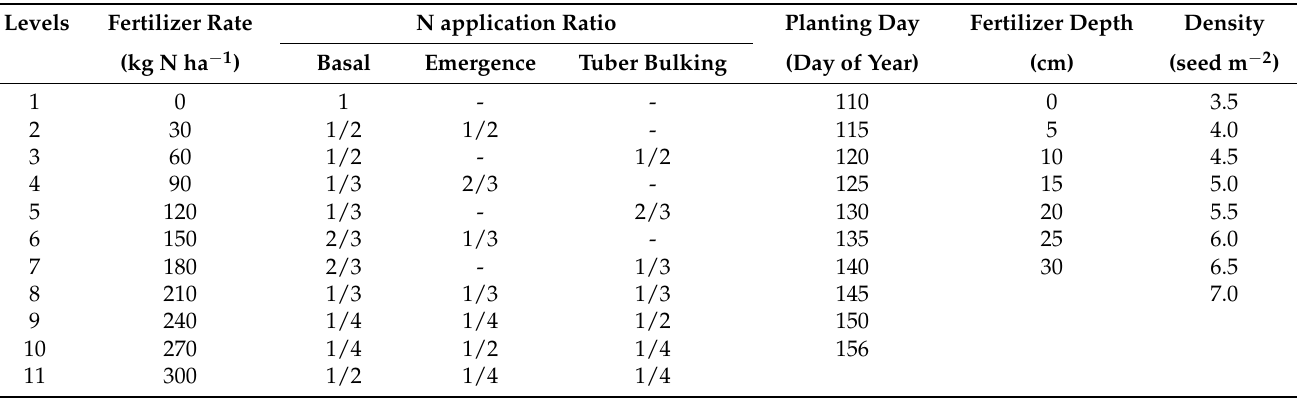
Table 2. The variable levels for sensitivity